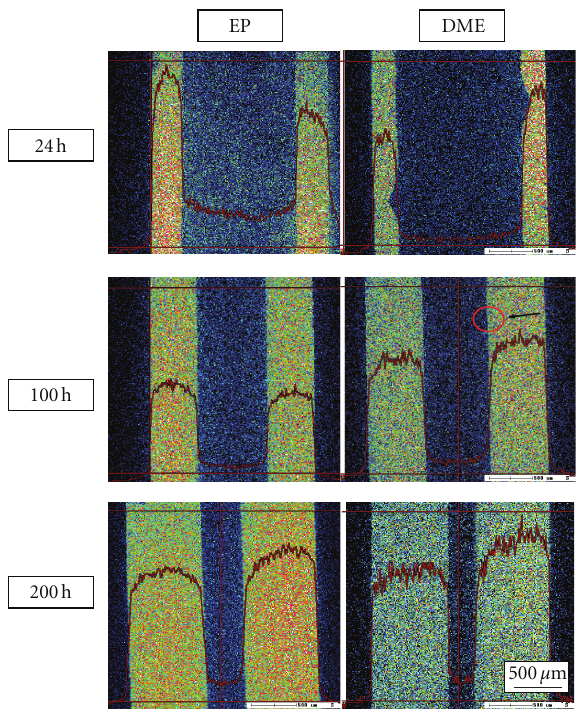
Figure 8: Penetration profiles of sulfur of neat epoxy (EP) and high- speed mixing (DME) nanocomposite at di ff erent immersion time under 10% of sulfuric acid solution.